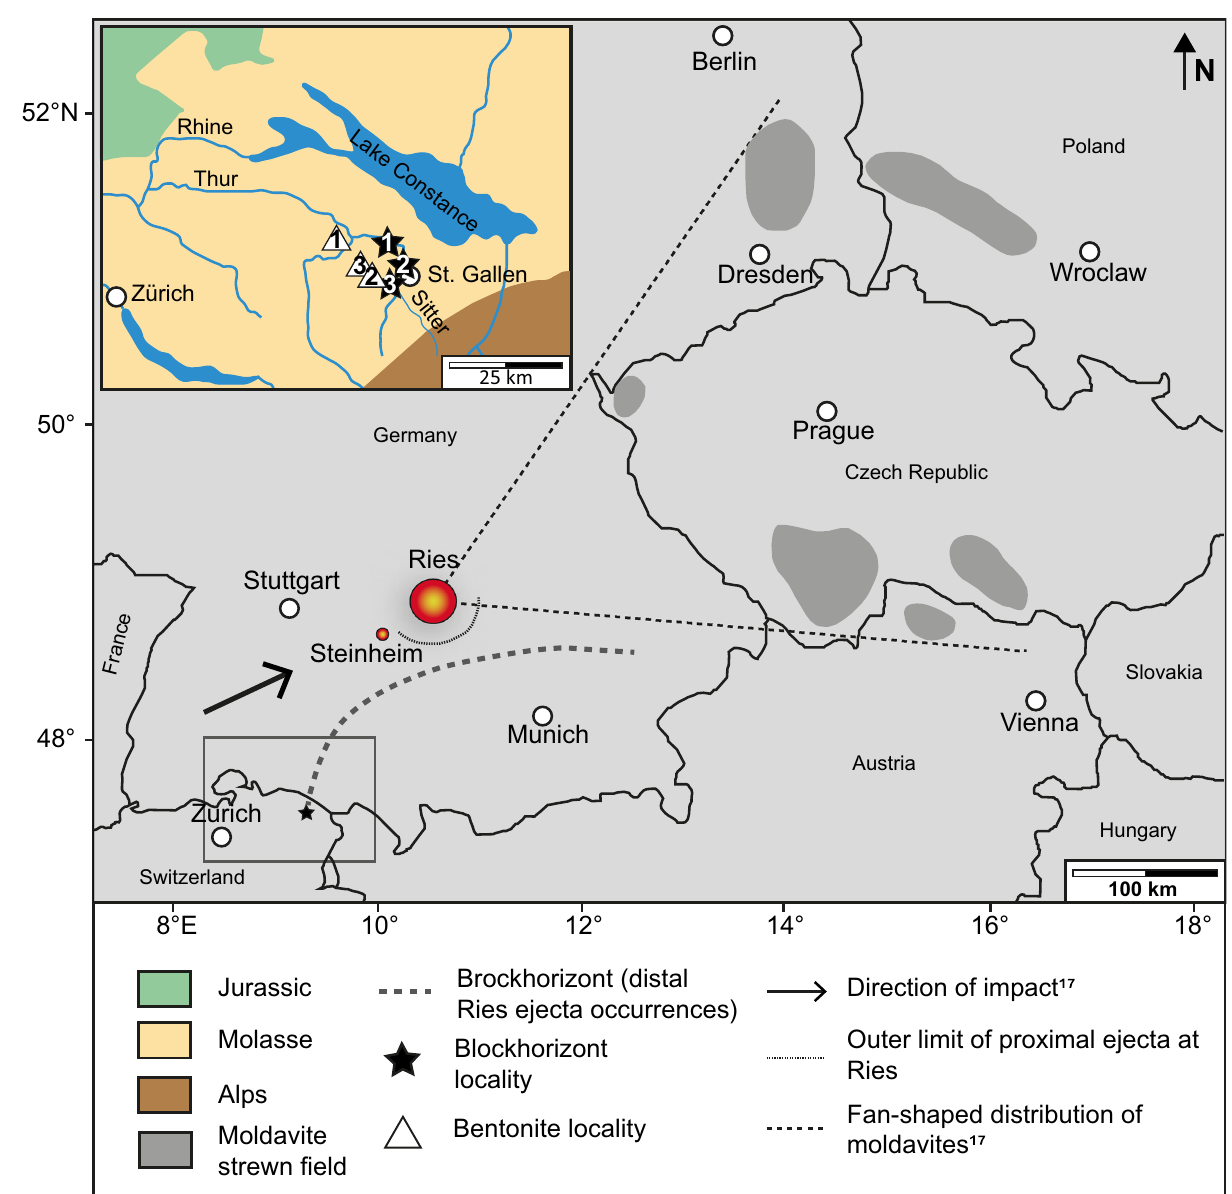
Figure 1. Map showing the location of the Ries and Steinheim impact structures, along with the distribution of proximal and distal impact ejecta from the Ries. Inset is a close-up showing the general geology of the area with the three localities where the Blockhorizont has been recognized in Switzerland (stars), and sample localities for the bentonite samples (triangles). Gray dashed line connects localities of the Brockhorizont, where limestone clasts have been found and are interpreted as distal Ries ejecta (note that this does not mean that the distal ejecta from Ries do not occur beyond this line; e.g. Ref. 16 ), with the Blockhorizont in Switzerland. Note the historical difference between the names “Blockhorizont” (the name for the enigmatic horizon in Switzerland 11 ) and “Brockhorizont” (the name of the horizon located in molasse in southern Germany containing distal ejecta particles also interpreted to come from the Ries). Star 1: Bernhardzell (samples investigated in this study), star